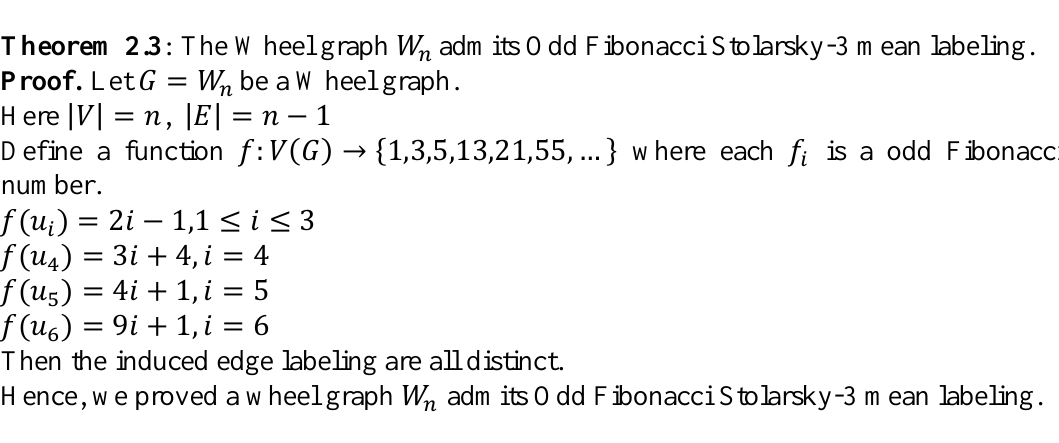
Figure 2.1: Bull